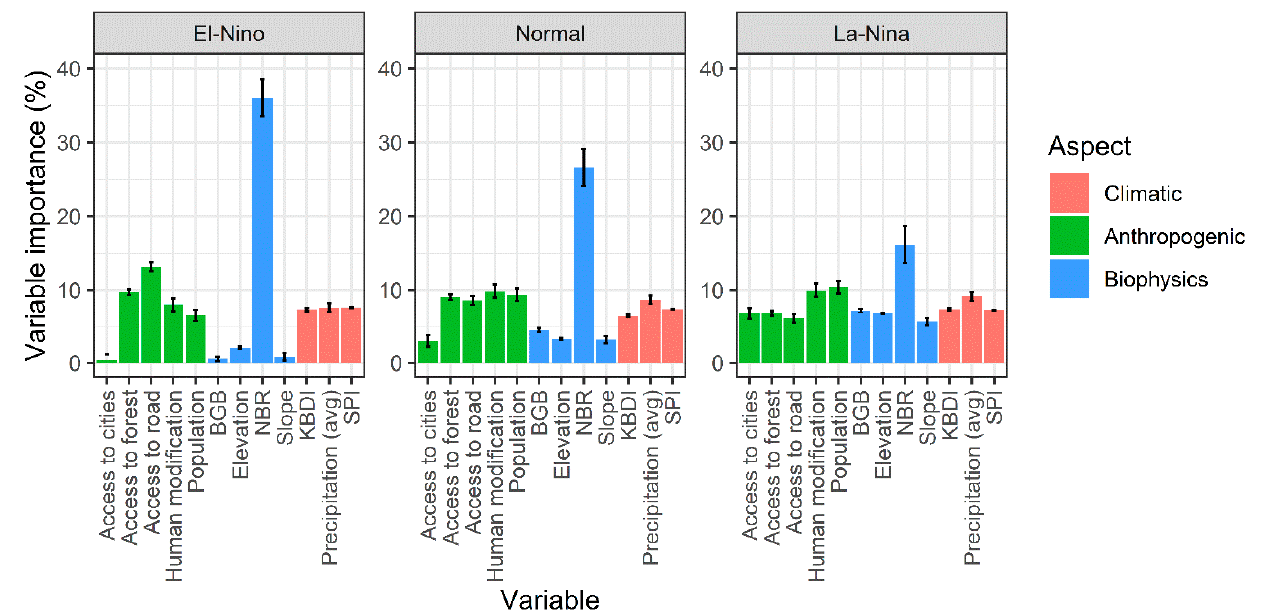
Figure 9. Variable contribution under different ENSO phases.